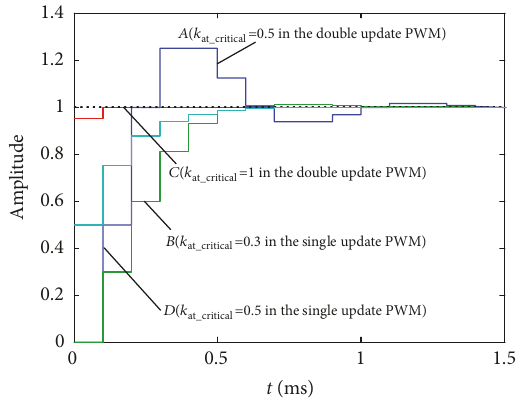
Figure 11: Contrast analysis of system response to unit step change between the single update PWM and proposed method.